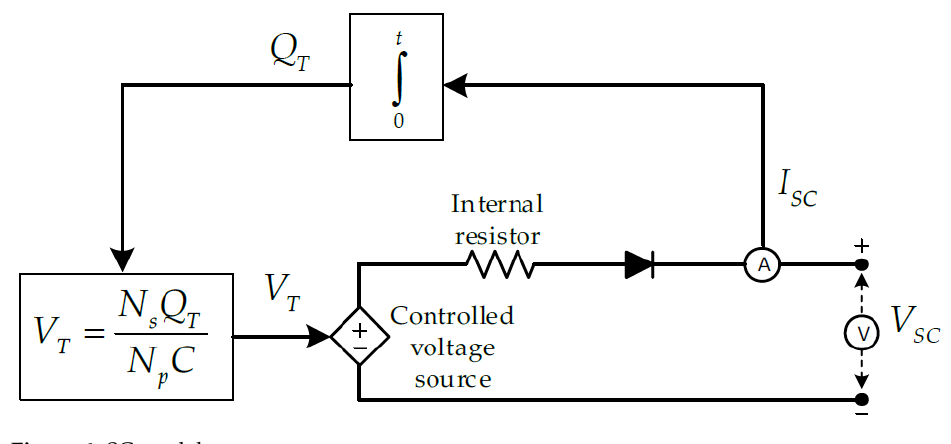
Figure 6. SC Figure 6. SC model.